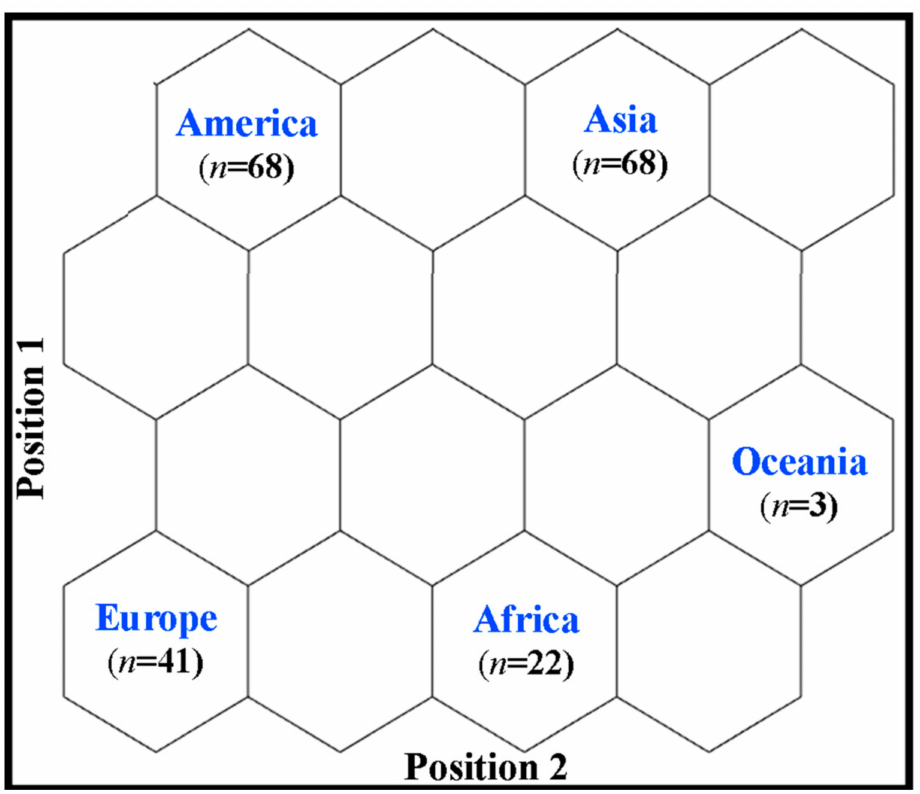
Figure 5. Continents distribution according to the winning